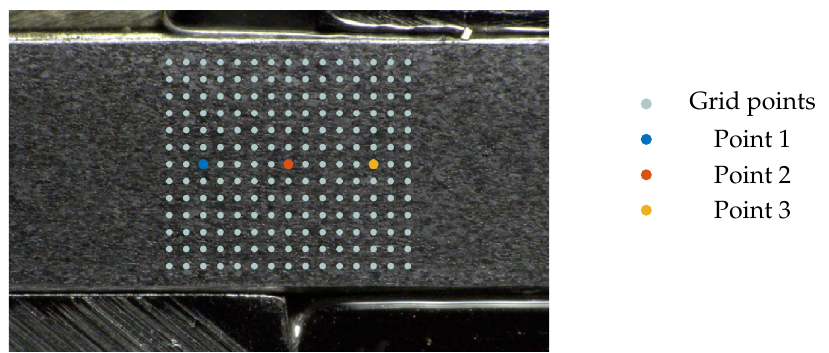
Figure 10. Material points selected or the visualization of the temporal course of the scale